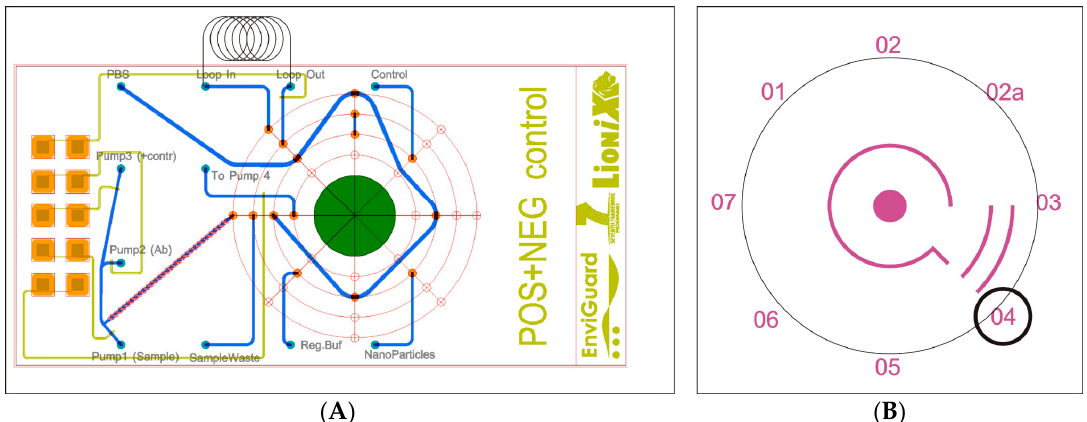
Figure A1. Design of the fluidic valve-chip ( A ) and the rotor ( B ). ( A ) Etched channels are in blue; connections towards the rotor are orange dots; connections towards the system are in light blue. The green circle is the cutout through which the rotor’s axe will pass. The mixing structure is indicated with the dotted line. ( B ) The channels on the rotor. The rotor is currently shown as in position “4” of the protocol.